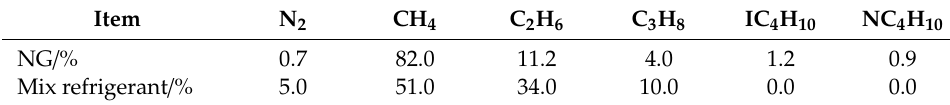
Table 3. Molar composition of NG and mix